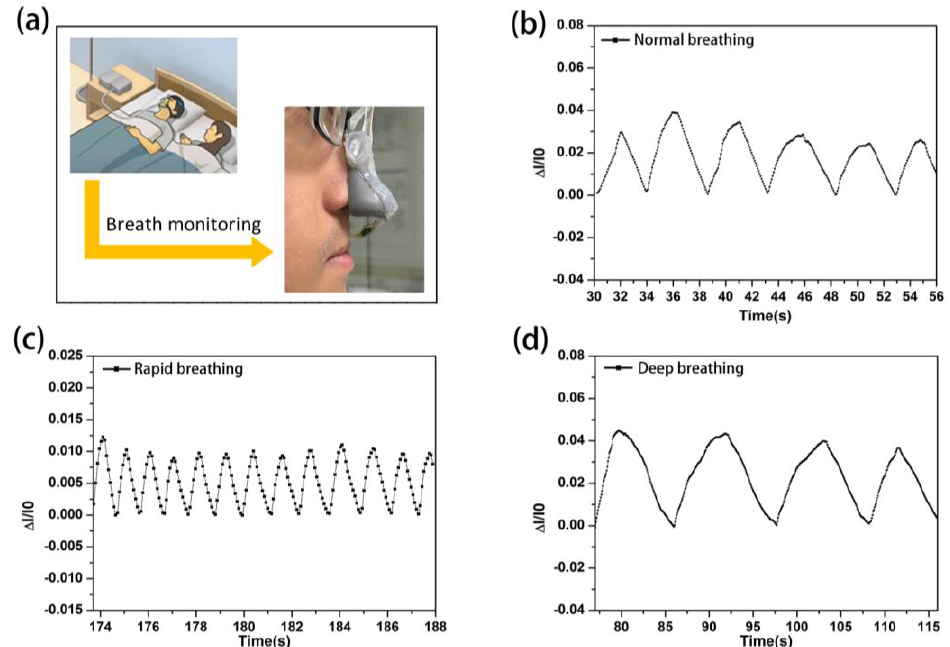
Figure 5. ( a ) Ionogel-based sensor. ( b ) Relative current changes of common respiration. ( c ) Relative current changes of rapid breathing. ( d ) Relative current changes of deep respiration. 171